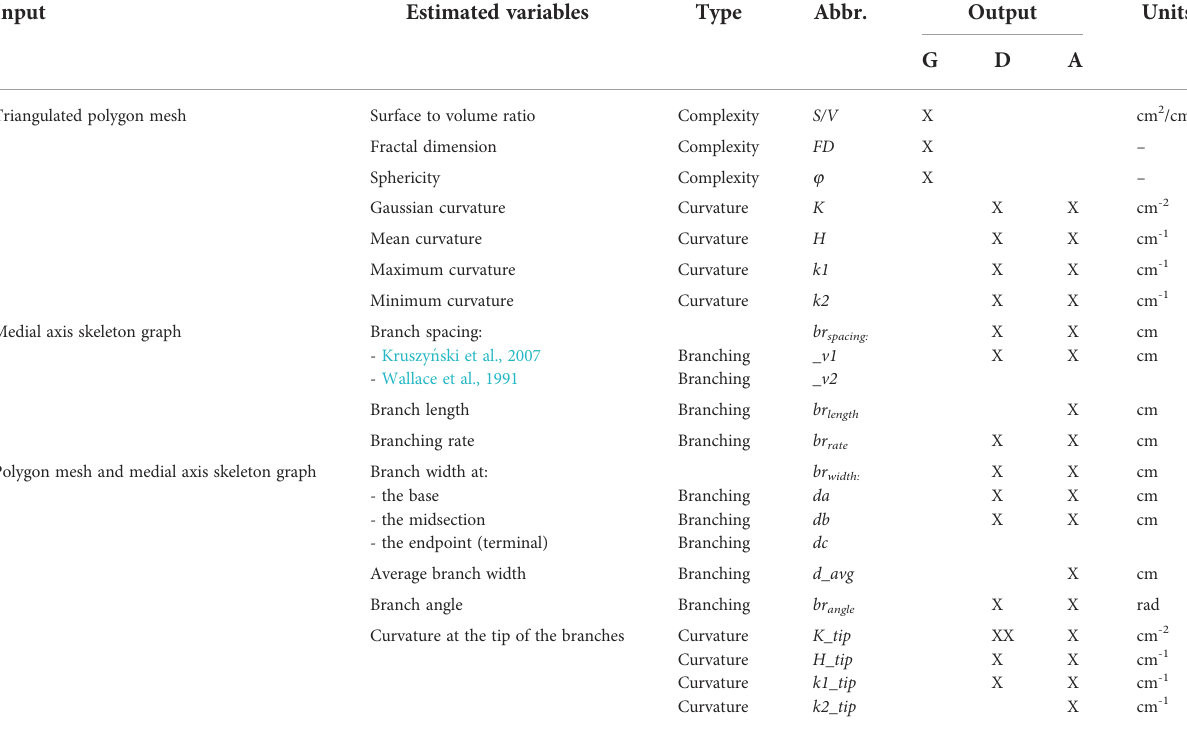
TABLE 1 Outline of the quantitative morphological variables assessed from the 3D data (triangulated polygon meshes and extracted medial axis skeletons) according to their type: branching, complexity, and curvature. Input